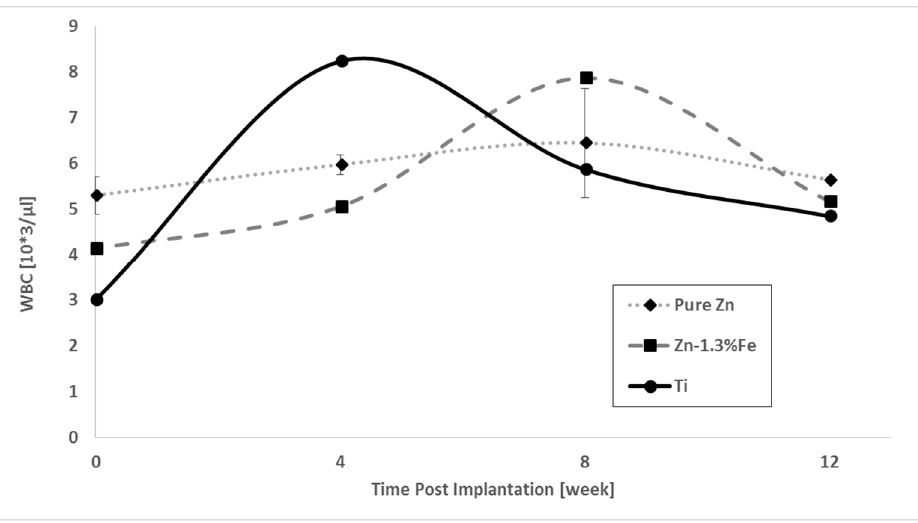
Figure 14. White blood cells (WBC) level pre- and post-implantation.